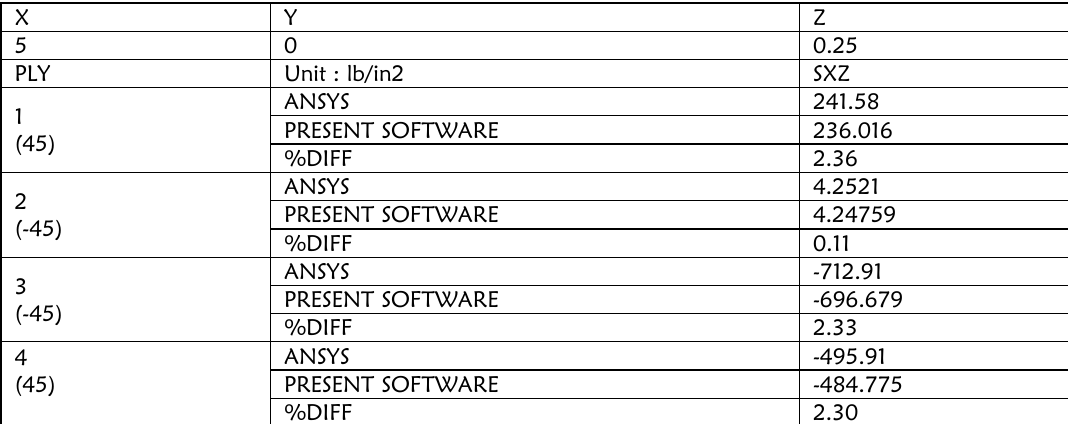
Table 4: Shear stress on the web of T-beam due to